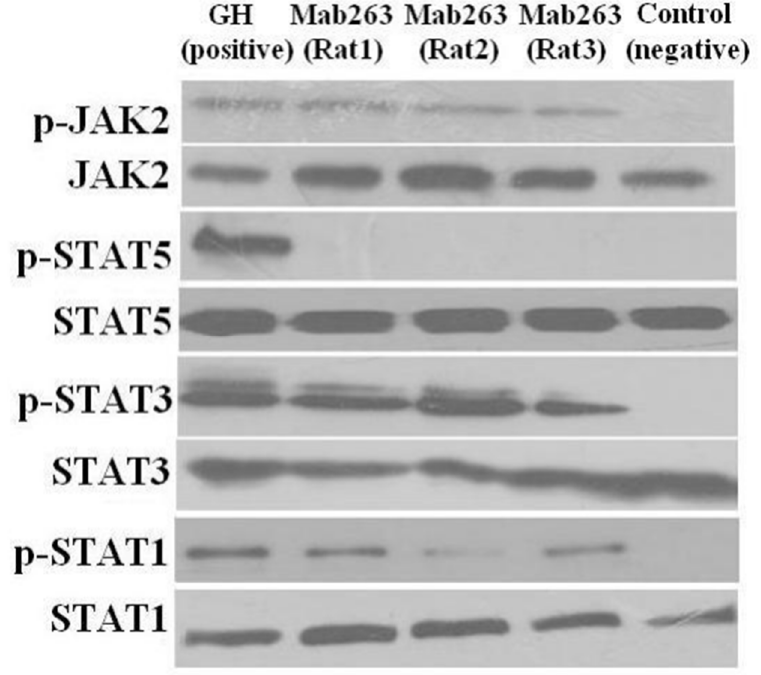
Figure 5. The intracellular signaling pathway(s) induced by Mab263 in vivo . Rats were stimulated with GH, Mab263 or control antibody for 20 min, as described in the Materials and Methods. The rats were sacrificed by decapitation, and the livers were quickly removed. The tissue samples were homogenized in ice-cold lyses buffer with a pestle and then maintained at 4 °C for 30 min with continuous shaking. The samples were then centrifuged, collected and lysed directly in SDS-PAGE sample buffer boiled for 5 min and quantitated with a BCA kit. The samples were then separated by SDS-PAGE and transferred to a PVDF membrane. After blocking and washing, the membranes were probed with antibodies recognizing p-JAK2 and p-STAT1/3/5. After washing, secondary antibody ( horseradish peroxidase (HRP)-goat anti-mouse) was added to detect the bound antibody using the ECL detection system. After detection, the membranes were stripped and re-probed with antibodies to the total JAK2, STAT1/3/5 and ERK proteins to verify equal protein loading in each lane. ( Bottom ) The corresponding histogram of data from three separate western blot analyses. Densitometry data for p-JAK2, p-STAT1/3/5 and p-ERK1/2 were normalized to that of total JAK2, total STAT1/3/5 and total ERK1/2, presented as RDU and expressed as the means ± SE. * p < 0.05 compared with the control values; p,